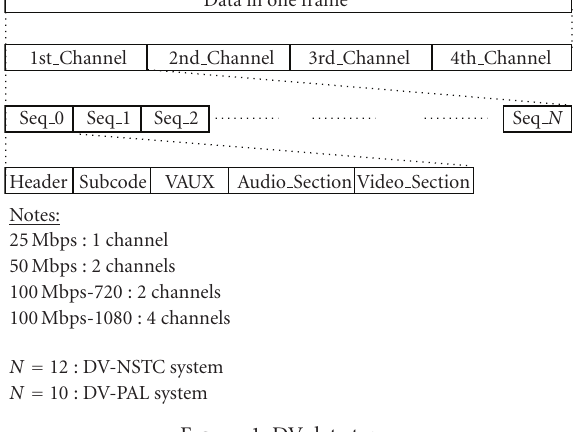
Figure 1: DV data